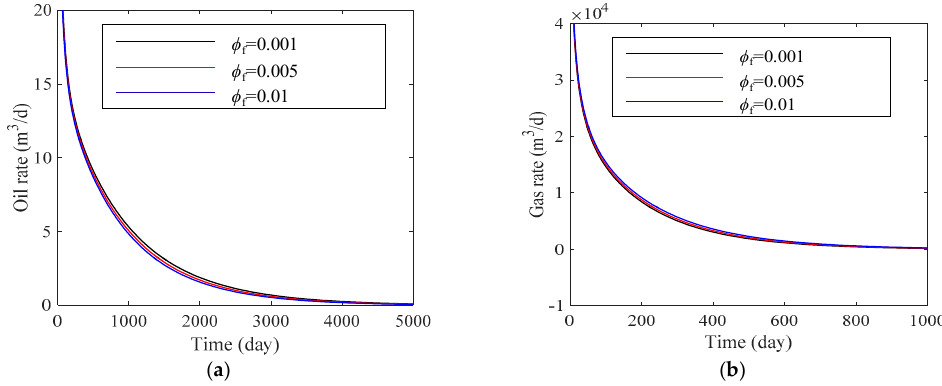
Figure 8. Effect of fracture porosity on production rate: ( a ) effect of fracture porosity on oil production rate; ( b ) effect of fracture porosity on gas production rate.